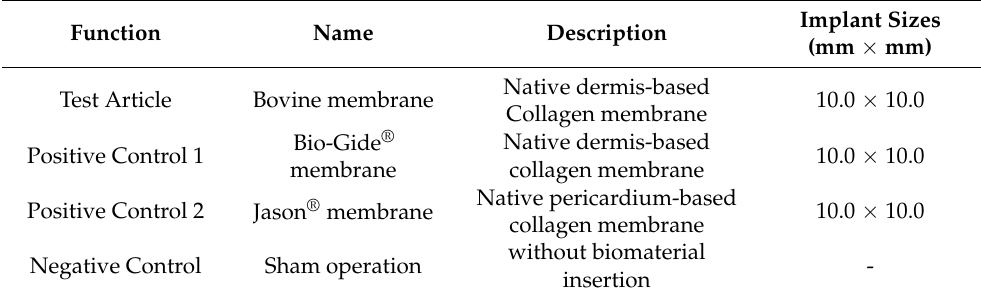
Table 1. Test and Control Article